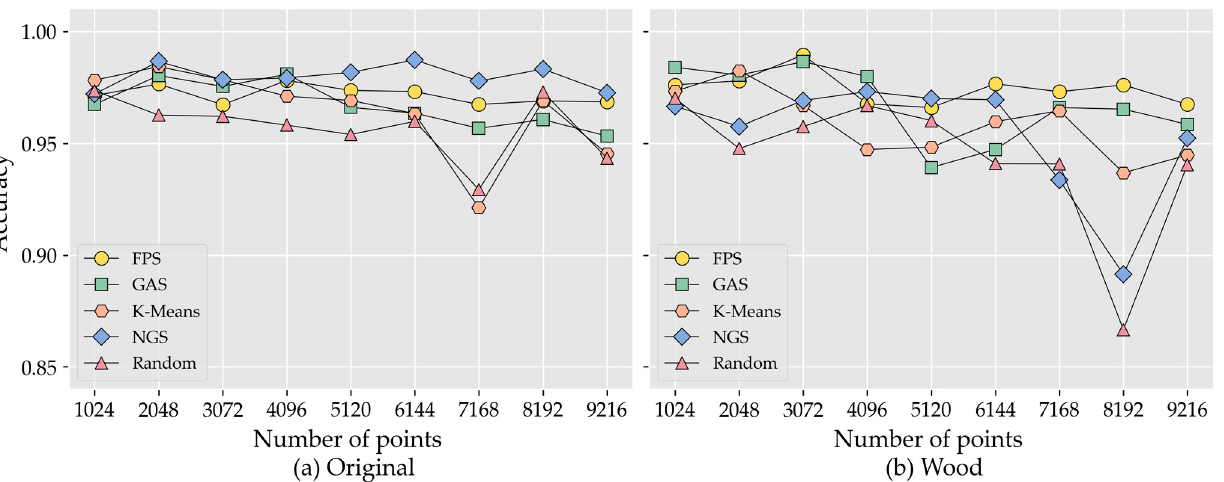
Figure 8. Accuracy of tree species classification in experiments with different downsampling meth- ods: ( a ) point cloud data without leaf–wood separation; ( b ) point cloud data of the wood.